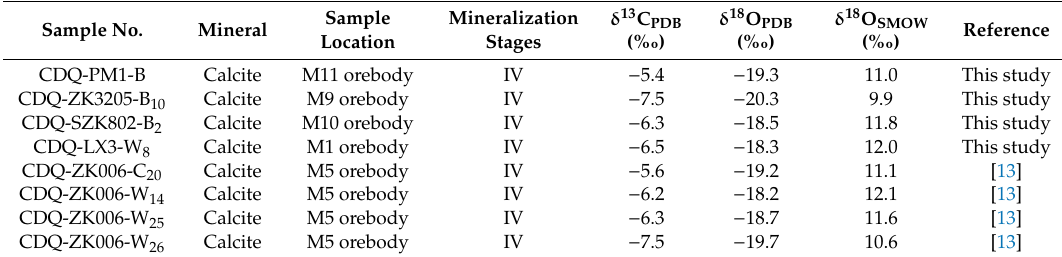
Table 4. The C–O isotopic compositions of the Chuduoqu Pb-Zn-Cu deposit. Sample No.